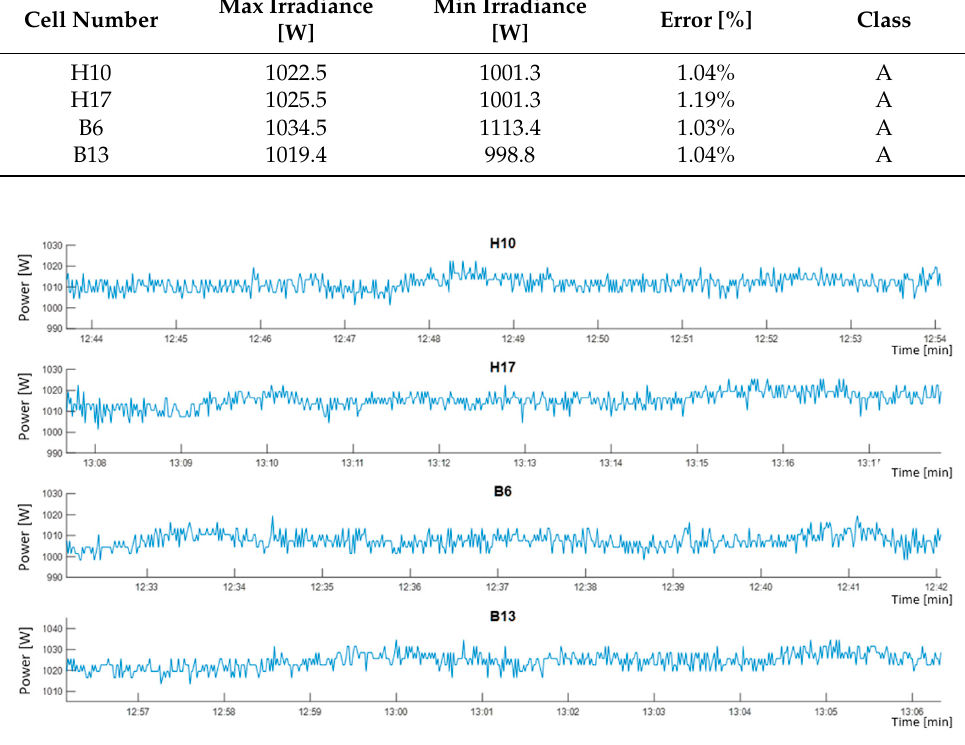
Figure 9. Long ‐ term instability test results. Figure 9. Long-term instability test